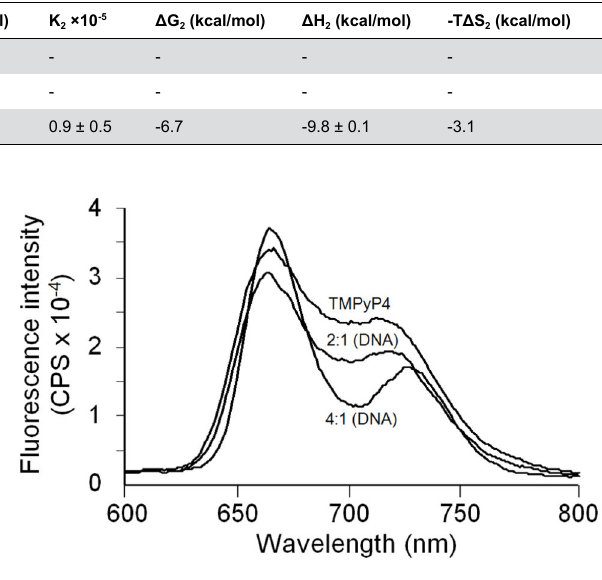
Figure 5. Fluorescence emission spectra obtained for the TMPyP4 in the presence or absence of 39-mer Bcl-2 G- quadruplex DNA. Spectrum 1 labeled TMPyP4 is for the free porphyrin (in the absence of DNA). Spectrum 2 is for TMPyP4 in the (TMPyP4) · 39-mer Bcl-2 complex. Spectrum 3 is for 2 TMPyP4 in the (TMPyP4) · 39-mer Bcl-2 complex. 4